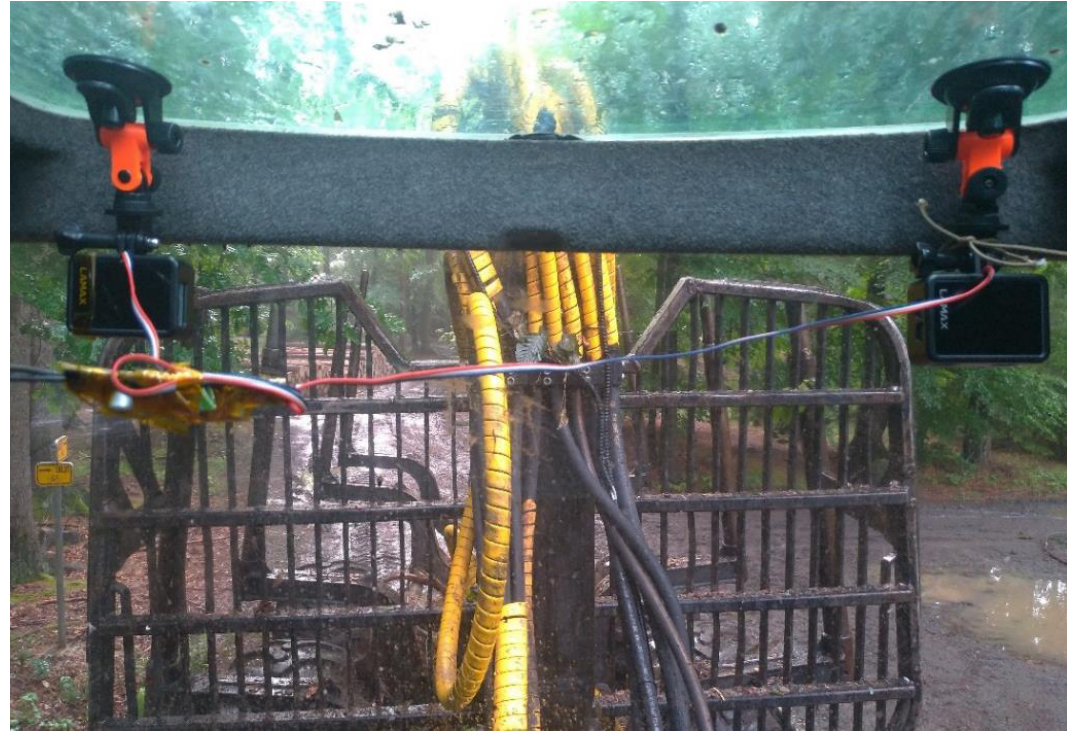
Figure 1. Placement of the cameras in the cabin.